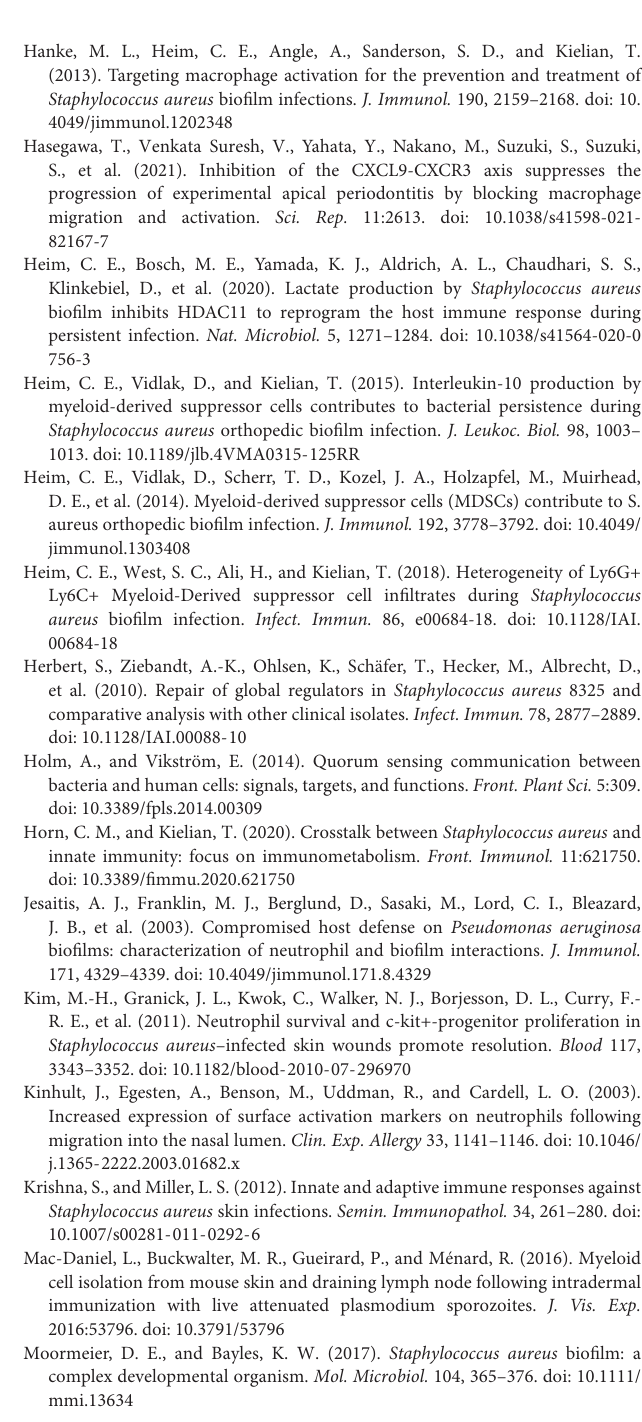
bacteria from 2.50 to 3.10 hpi. Average projections of time-lapse images. Z-stacks collected 72.98 s apart. Scale bar: 100 µ m. Supplementary Movie 2 | EGFP + innate immune cells are recruited toward a biofilm injection site. In vivo confocal time-lapse imaging of immune cell migration in LysM-EGFP transgenic mice ear tissue injected with planktonic bacteria from 2.55 to 3.25 hpi. Average projections of time-lapse images. Z-stacks collected 106.55 s apart. Scale bar: 100 µ